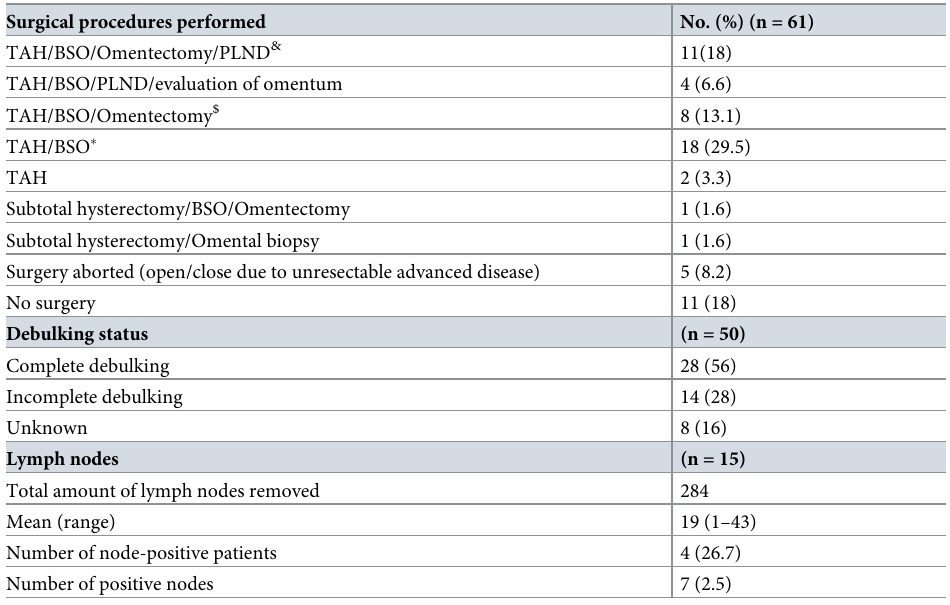
Table 2. Surgical management and debulking status of patients. Surgical procedures